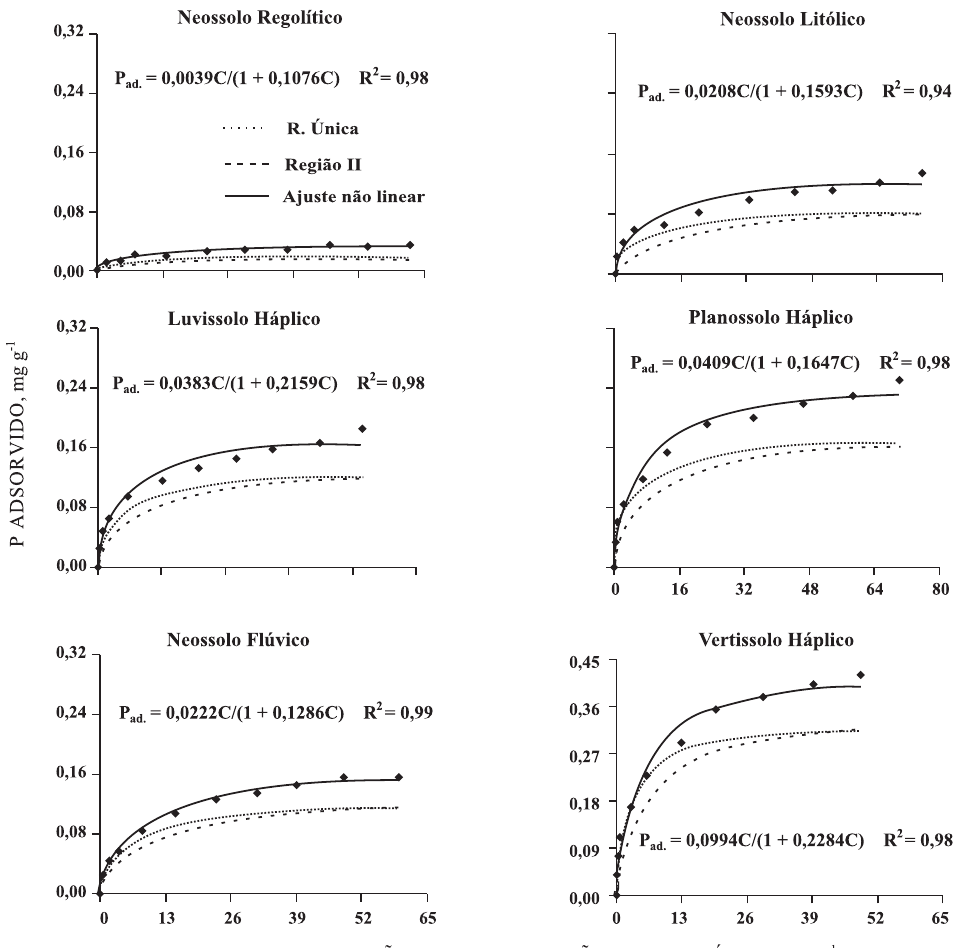
Figura 2. Ajuste do modelo hiperbólico da isoterma de adsorção de Langmuir por meio de ajuste de regressão não linear e da linearização do modelo hiperbólico (região única e região II), para a quantidade de P ) nos solos menos intemperizados representativos do Estado da Paraíba como variável da adsorvida (P ad. concentração de P na solução de equilíbrio